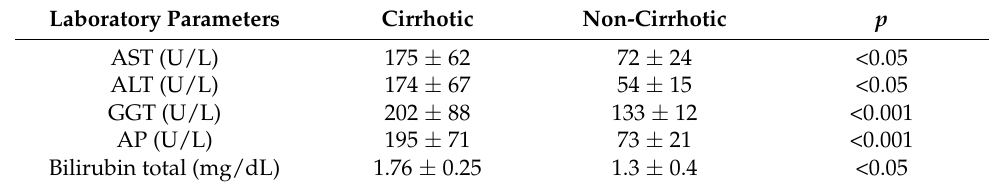
Table 1. Laboratory parameters in HCV-infected patients. Laboratory